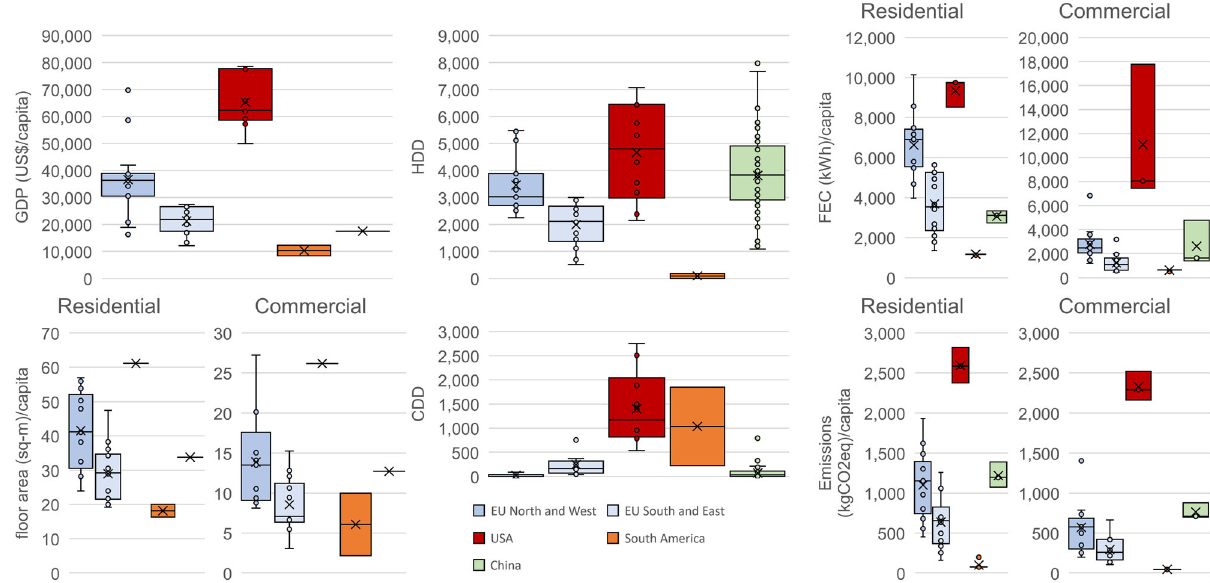
Fig. 1 Status quo (Year 2020): median of the gross domestic product (GDP), fl oor area, heating degree days (HDD) and cooling degree days (CDD), fi nal energy consumption (FEC), and CO 2 emissions by the studied region (Northern and Western (NW) Europe and Southern and Eastern (SE) Europe, and South America) or country (the USA and China). In this plot, each region is described by the countries within the region. In the case of the USA and China, as they are the only countries within their region modeled in this study, their distributions are taken as the distributions of their administrative